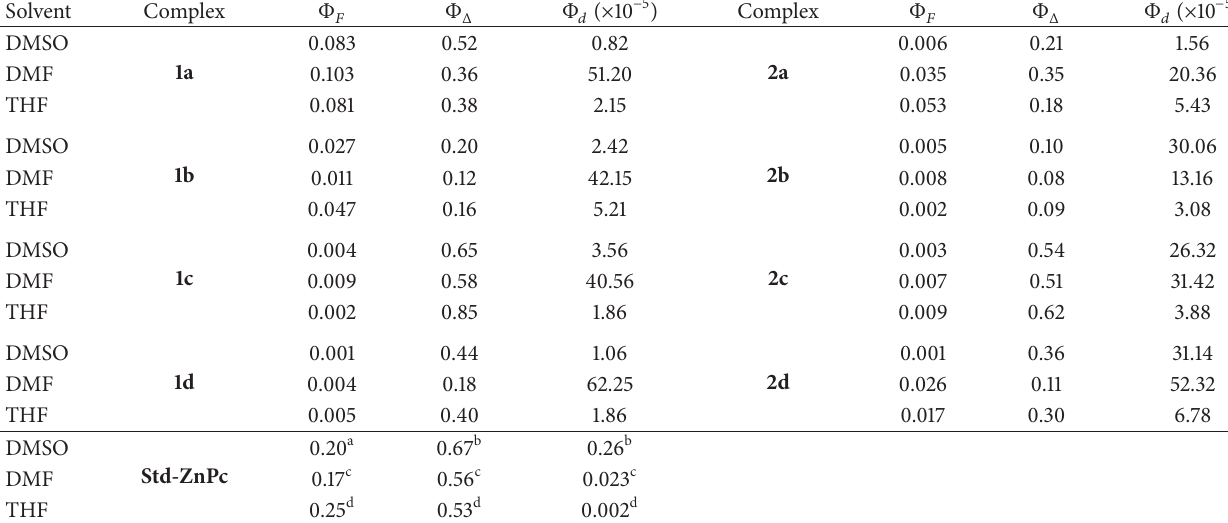
Table 2: Photophysical and photochemical properties of 1a–1d and 2a–2d in DMSO, DMF, and